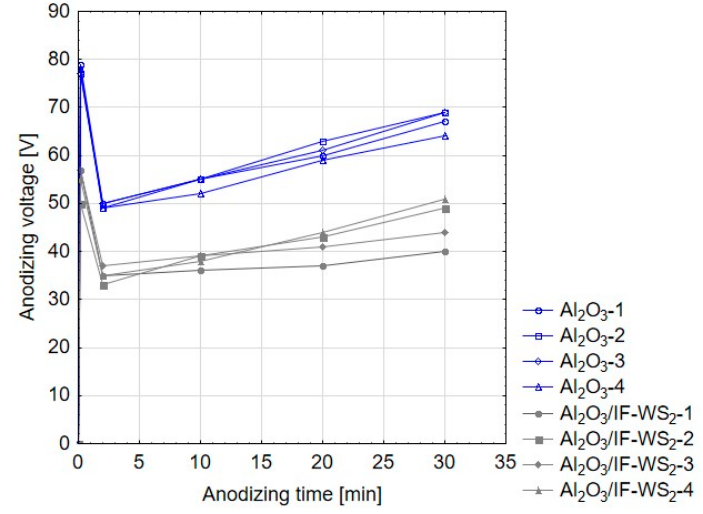
Figure 2. Anodizing voltage–time dependence for SAS and SAS electrolyte with admixture of IF-WS 2 .